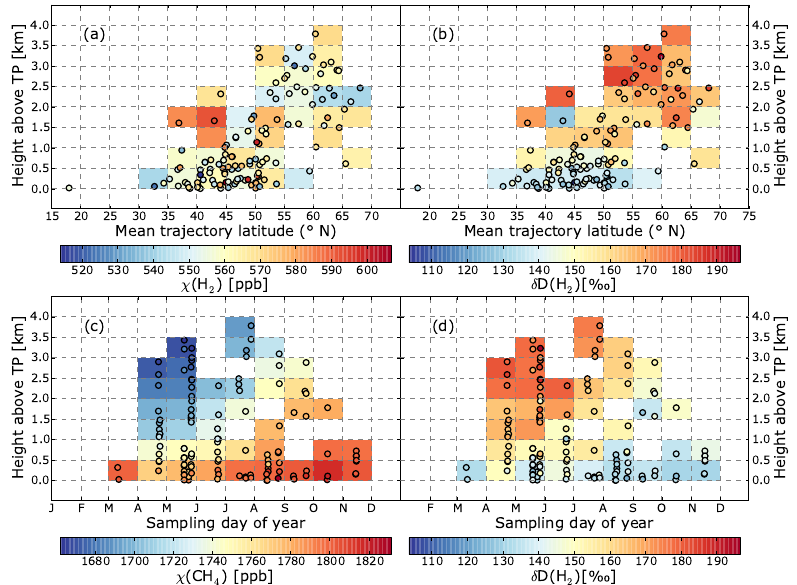
Fig. 4. Distributions of χ( H 2 ) (a) , δ D ( H 2 ) (b) , χ( CH 4 ) (c) and δ D ( H 2 ) (d) in the stratospheric samples plotted against height above the thermal TP (calculated from the O 3 measurements following the method of Sprung and Zahn (2010)) and mean trajectory latitude (calculated from the 15 five-day trajectories) (a, b) or time of year (c, d) . The rectangles are colored according to the averages of the samples in the